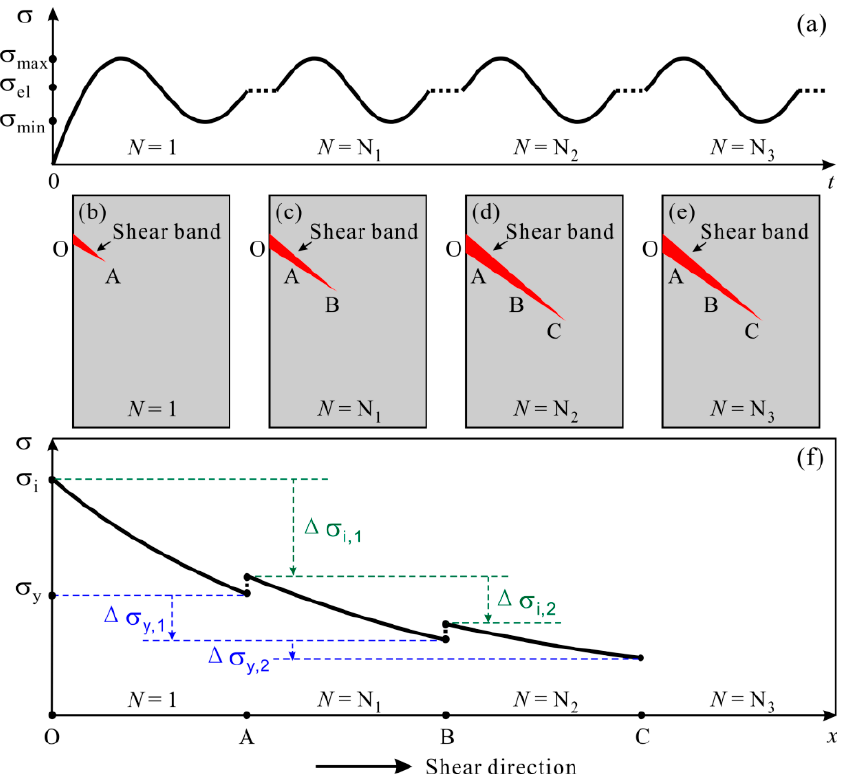
Figure 7. Schematic diagram illustrating the mechanism of progressive shear band propagation under cyclic compression of MGs [45]. ( a ) Illustration of applied cyclic stress ( σ ) as a function of loading time (t). ( b – e ) Illustrations of shear band propagation with increasing the number of loading cycle. ( f ) Possible stress distribution along the shear direction of Ox. σ i and σ y are the critical stresses for shear band initiation and propagation.